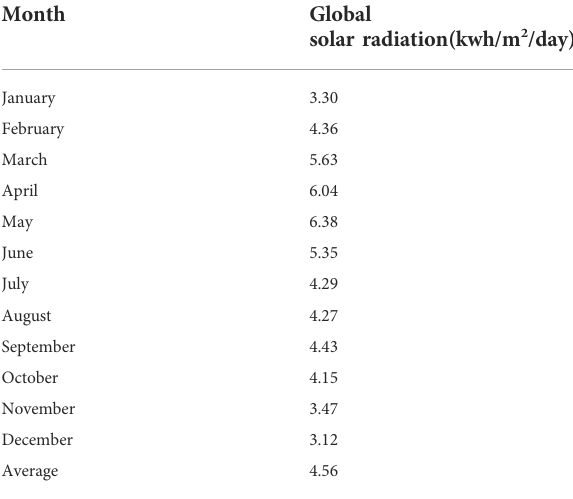
TABLE 4 Monthly variation of global solar radiation for the site location.